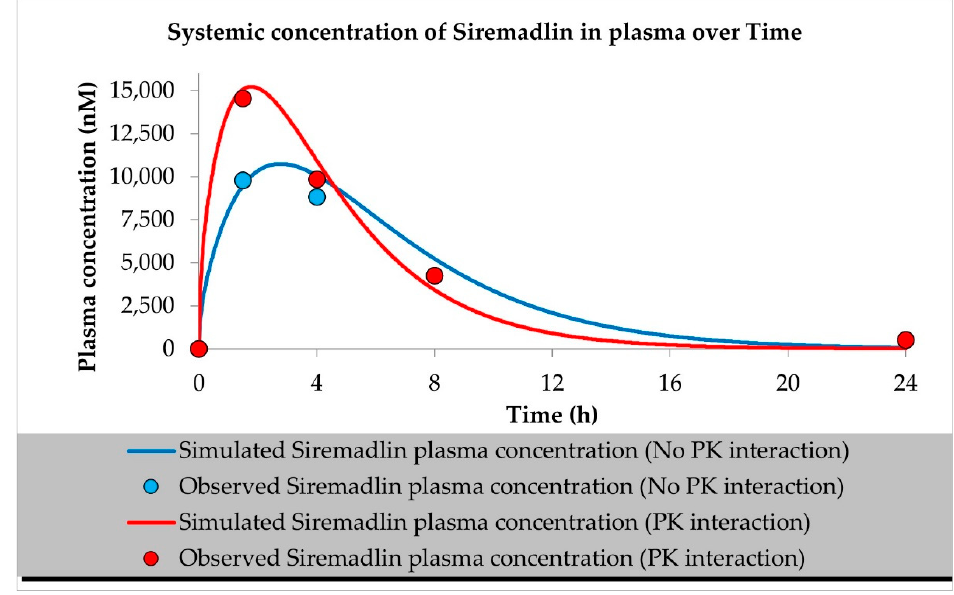
Figure 1. PBPK model of siremadlin with and without PK interaction. Observed data are means from n = 3.